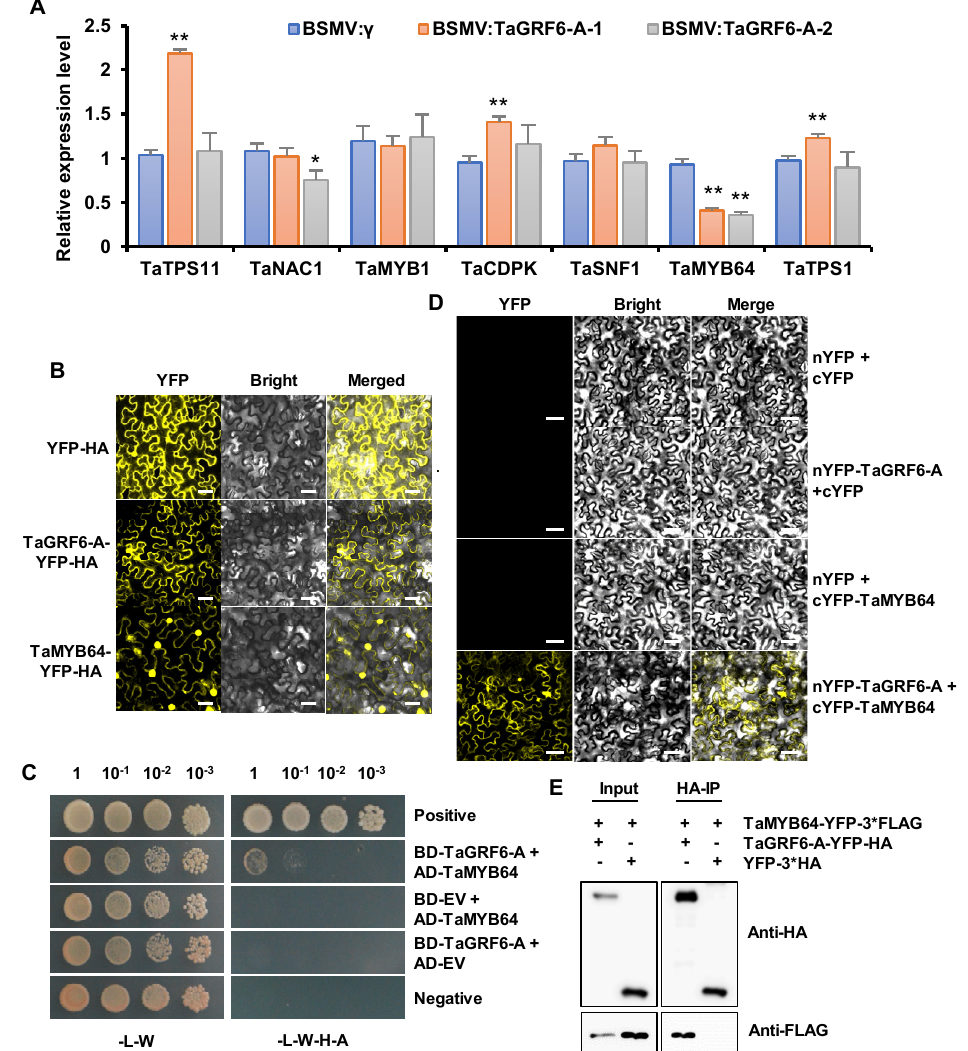
Figure 6. Analysis of protein interaction between TaGRF6-A and TaMYB64. ( A ) Relative expression levels of potential targets and stress-related genes in the leaves of TaGRF6-A -knockdown plants treated with 12 days of 300 mM NaCl. Error bars represent the SD of three biological replicates. The asterisks indicate statistical significance using Student’s t -tests. (**, p < 0.01; *, p < 0.05). ( B ) Subcellular localization of TaGRF6-A in N. benthamiana . Free YFP and TaGRF6-A-YFP and TaMYB64-YFP fusion proteins were transiently injected into N. benthamiana leaves by Agrobacterium (GV3101) transformation. Subcellular localization observed by laser confocal microscopy after 48 h post-infiltration. Scale bars, 40 µ m. ( C ) Yeast two-hybrid interaction results of TaGRF6-A and TaMYB64 proteins. -L-W refers to media lacking leucine and tryptophan, -L-W-H-A refers to media lacking leucine, tryptophan, histidine, and adenine. ( D ) BiFC assay showing interactions of TaGRF6-A and TaMYB64 proteins. Scale bars, 40 µ m. ( E ) Co-immunoprecipitation experiments show that TaGRF6-A interacts with TaMYB64 in planta. The total proteins of TaMYB64 with FLAG tag and TaGRF6-A with HA tag were extracted from N. benthamiana leaves. The immune complex was pulled down using anti-HA agarose gel, and the co-precipitation of TaGRF6-A and TaMYB64 was detected by Western